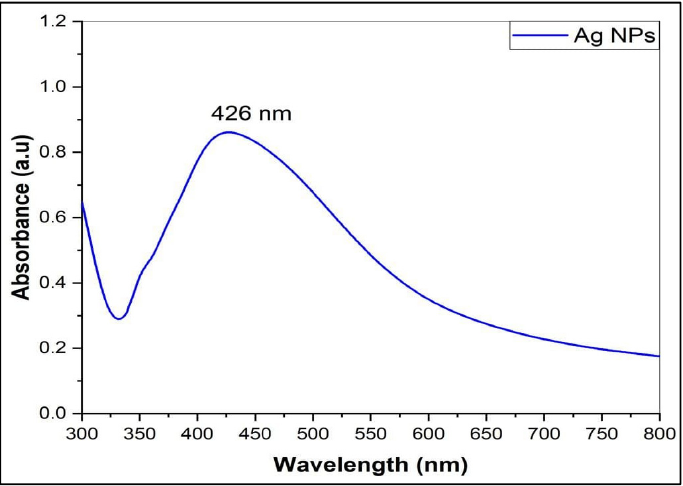
Figure 1. The UV-Visible spectrum of AgNPs. The Fourier Transform Infra-Red (FT-IR) spectrum of the prepared AgNPs was recorded to determine the presence of functional groups. The characteristic IR absorption major broad peak at ν max 3356.14 cm − 1 accounted for the presence of OH, and the sharp peak at 1643.35 cm − 1 attributed to the carbonyl (-C=O) stretching, together with minor peaks at 2350.06, 624.93, and 594.07 cm − 1 , which agreed with the absorption values of the previous studies on the citrate-capped AgNPs characterization [7,29] (Figure 2). Moreover, the AgNPs IR spectrum differed from the starting material, silver nitrate, which exhibits a characteristically strong metal nitrate peak and is devoid of the hydroxyl function peaks. The AgNPs spectrum also differed with the SDS and TSC, the emulsifier and capping agent used in the synthesis, respectively. The synthesis of the AgNPs was also confirmed by other analyses and morphological observations.